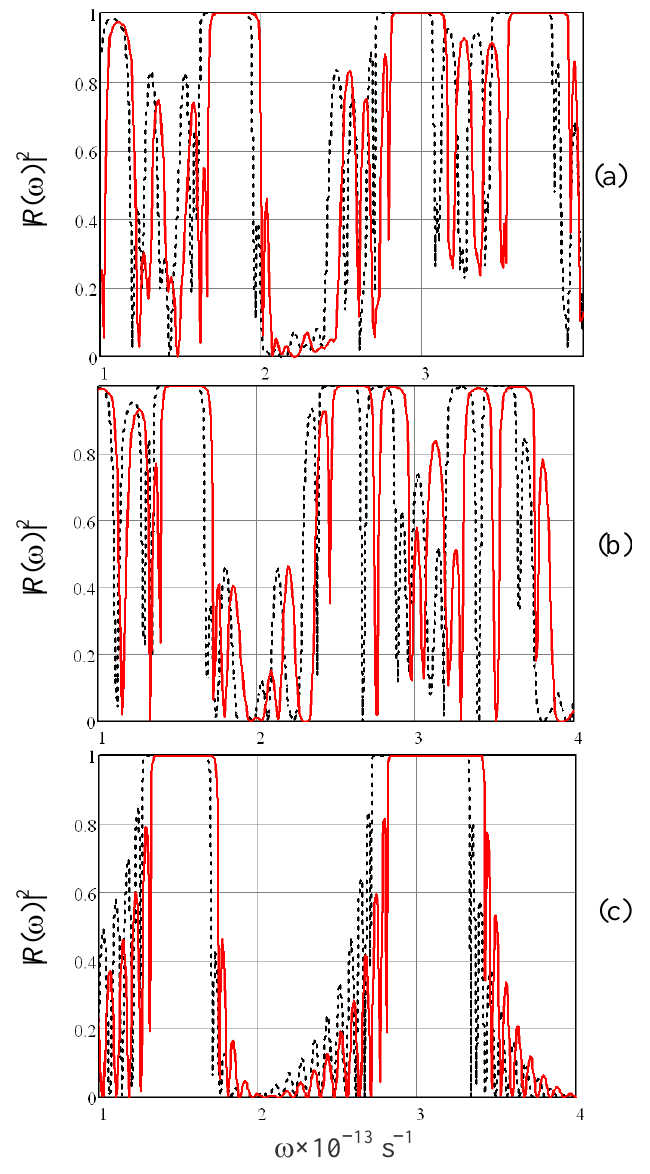
Figure 2. Reflectance of TM wave incident at Θ (solid red lines) on ( a ) Fibonacci S with 16 unit